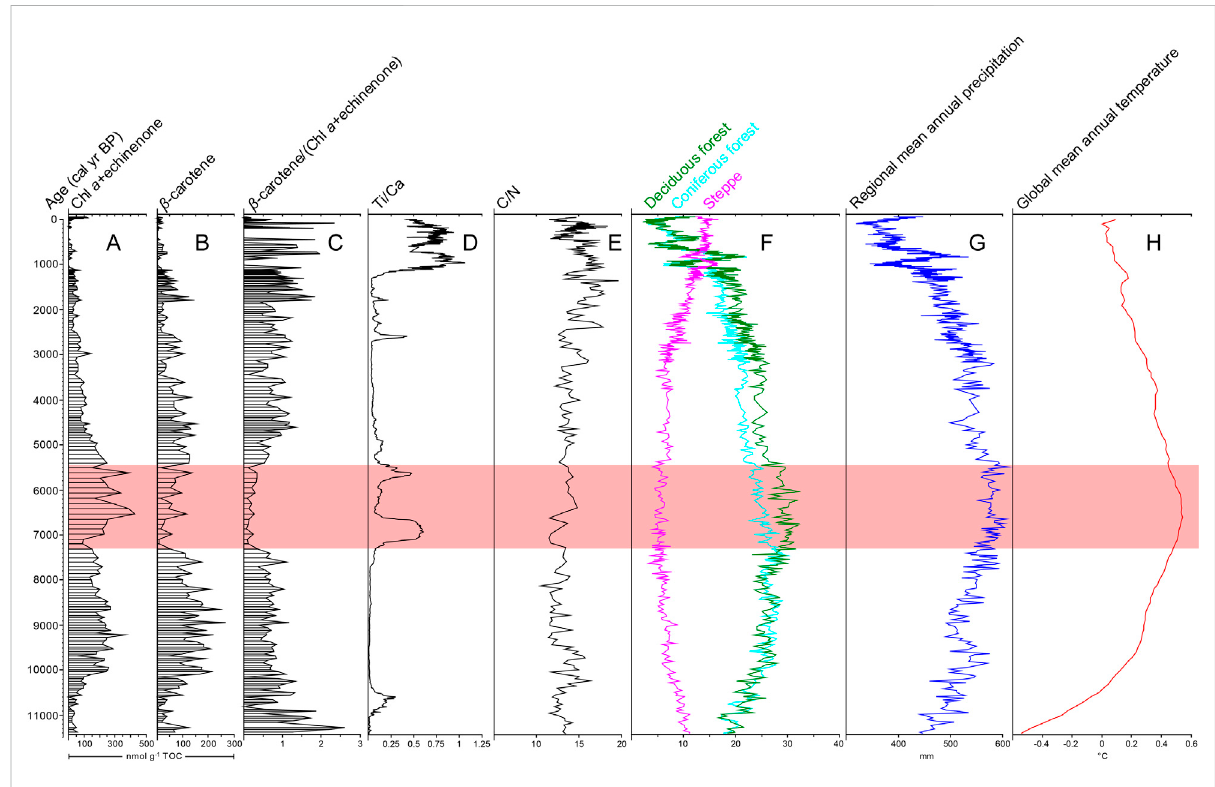
FIGURE 4 Comparison of Holocene pigment data from Lake Mayinghai (A – C) with Ti/Ca (D) (Shen et al., 2018; Cheng et al., 2020) and C/N (E) (Cheng etal.,2020;Lietal.,2020)fromthesamecore,terrestrialvegetationbiomesfromnearbyLakeGonghai (F) (Xuetal.,2017),meanannualprecipitation innorthernChina (mainly EastAsiansummer monsoon precipitation) (G) (Chen etal.,2015)and global meanannual temperature (H) (Kaufman etal.,